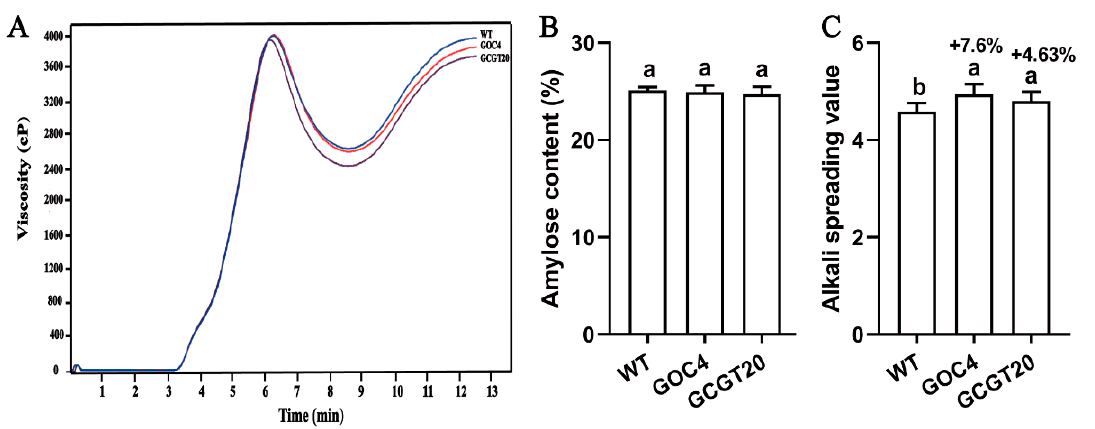
Figure 3. Cooking quality of GOC4, GCGT20, and WT rice grains. The cooking quality includes ( A ) the starch RVA curve, ( B ) amylose content, and ( C ) alkali spreading value. Data are presented as the mean ± SD according to one-way ANOVA followed by a Duncan’s test for means comparison. Different letters indicate significant differences ( n = 4, p < 0.05) . Table 1. Starch viscosity parameters of GOC4, GCGT20, and WT rice grains. Peak